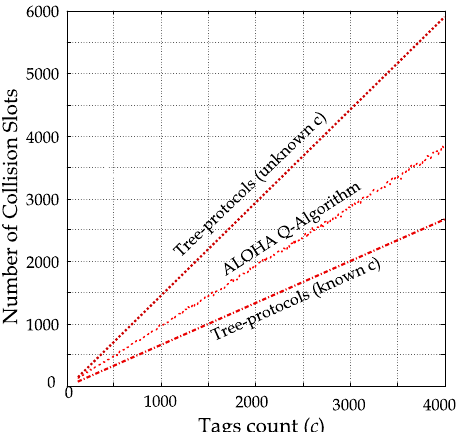
Figure 10. Total number of collision slots vs. different tag populations (from 100 to 4000 tags).